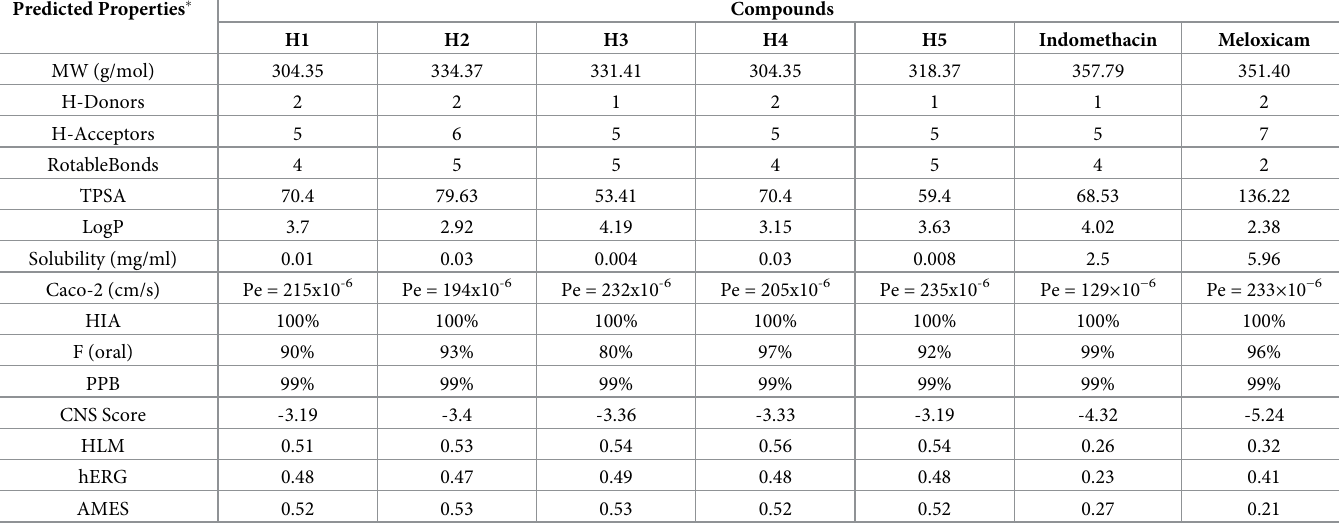
Table 3. Comparative in silico physicochemical properties and ADMET profile of the anti-inflammatory drugs indomethacin and meloxicam and new hydrazone series H1 to H5. Predicted Properties